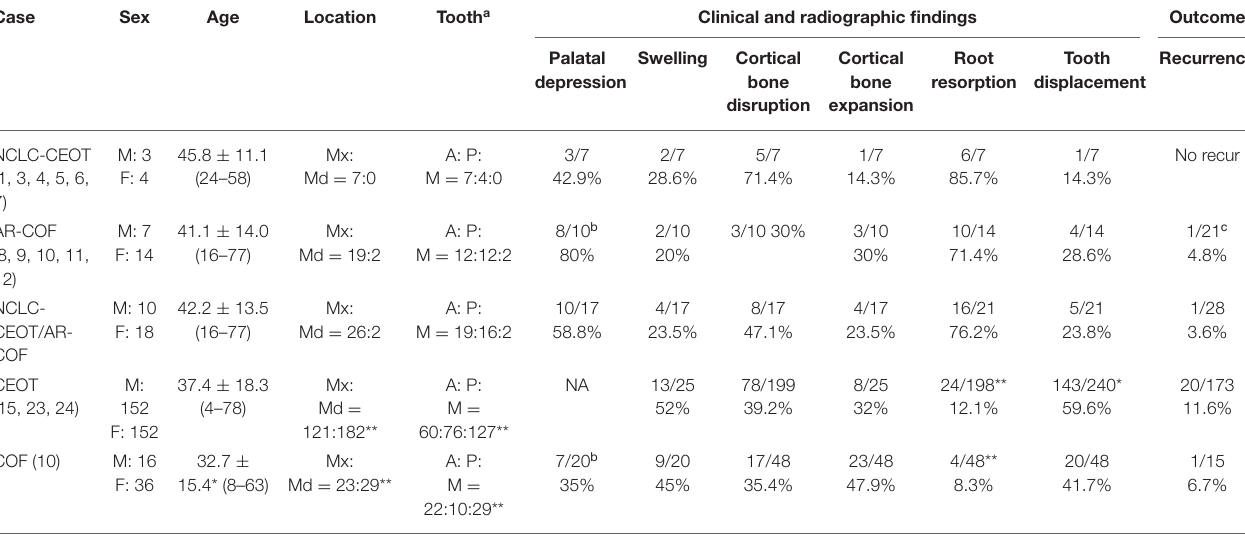
Root Tooth Recurrence Cortical Palatal Swelling Cortical resorption displacement bone depression bone expansion disruption